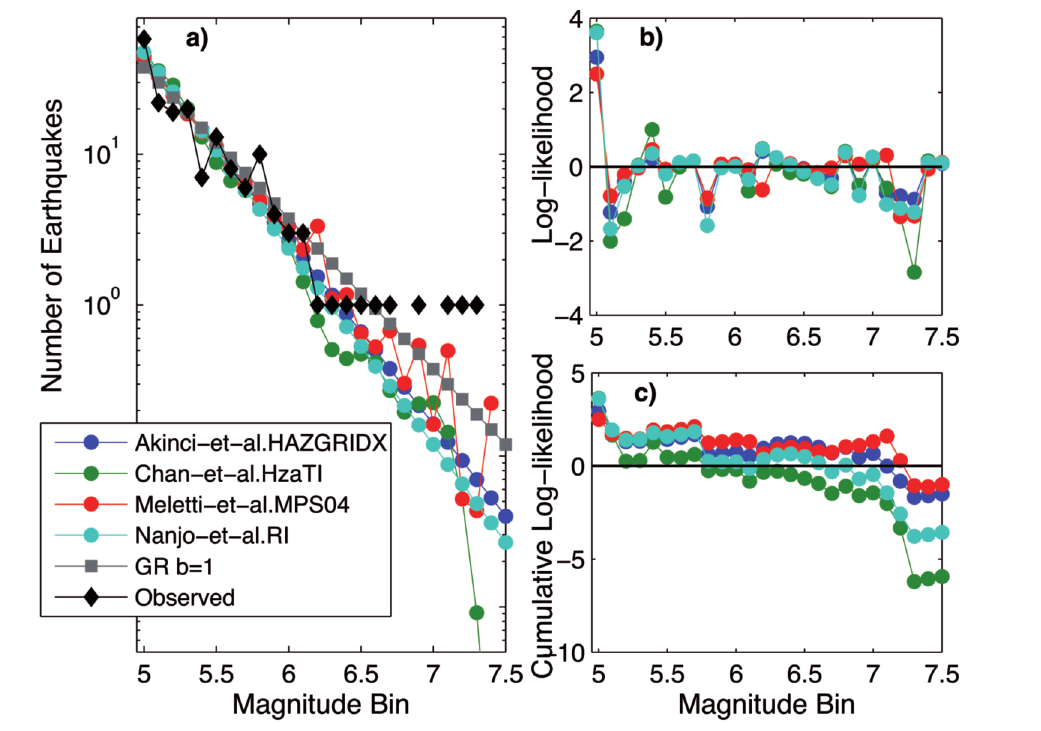
Figure 8. Magnitude distributions and likelihood scores for the four forecasts that failed the M-Test for the 106 year (1901-2006) CPTI target period, and, for comparison, a pure Gutenberg-Richter (GR) distribution with b -value equal to 1.0 ( b = 1), which passed the test. (a) Observed and predicted magnitude histograms, pure GR law. (b, c) Bin-wise log-likelihood ratios (b) and cumulative log-likelihood ratios (c) of the forecasts against the pure GR